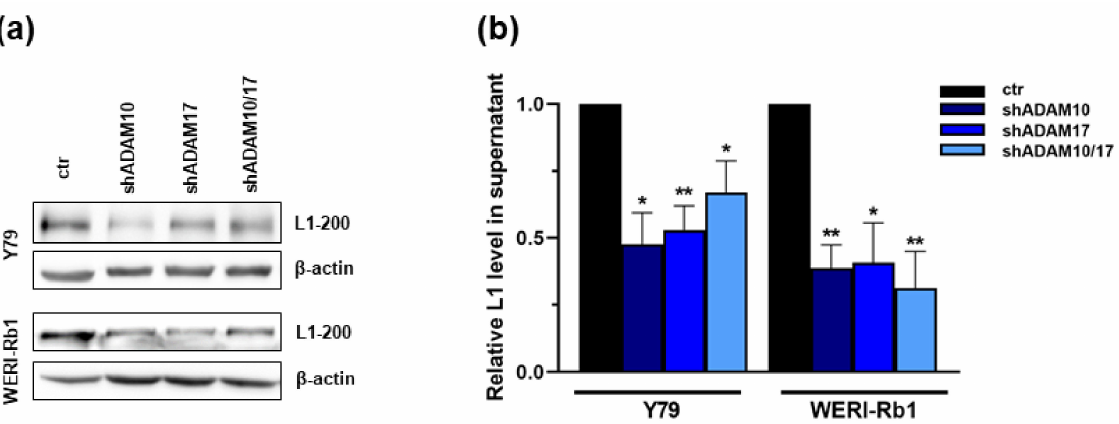
Figure 8. Analysis of L1CAM ectodomain shedding after ADAM10/17 single and double knockdown in Y79 and WERI-Rb1 cell lines. Western blot analysis of ADAM mediated L1CAM ectodomain (L1– 200) shedding in cell culture supernatant of Y79 and WERI-Rb1 cells 72 h after ADAM10 (shADAM10), ADAM17 (shADAM17) single and ADAM10/17 (shADAM10/17) double knockdown in comparison to control cells (ctr). Representative western blots of L1 shedding upon ADAM knockdown ( a ) and quantification of the L1CAM ectodomain expression reveals a significant reduction of L1-200 shed- ding after ADAM10/17 single and double knockdown in the RB cell lines Y79 and WERI-Rb1 ( b ). Indicated intensity ratios relative to ß-actin, used as a loading control, were calculated using MICRO MANAGER 1.4 software. Values are means of three independent experiments ± SEM. * p < 0.05 and ** p < 0.01 statistical differences compared to the control (ctr) group calculated by Student’s t